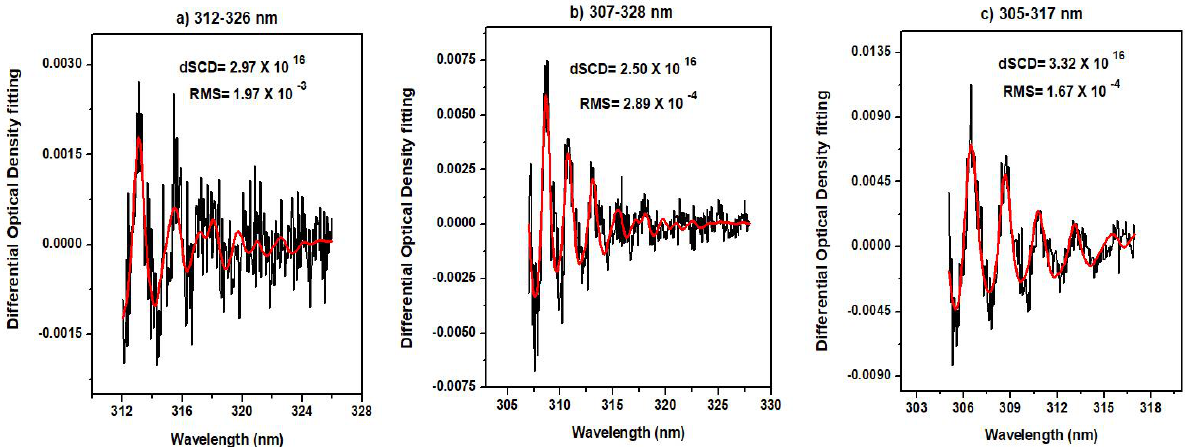
Figure 6. SO 2 DOAS Fit for fitting windows ( a ) 312–326, ( b ) 307–328, and ( c ) 305–317 nm at 2 ◦ elevation angle. The red lines represent the fitted optical density, while measured densities are shown by black lines.